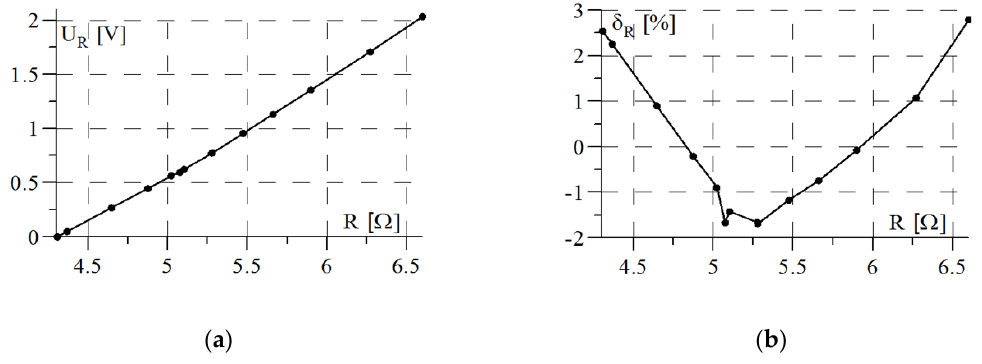
Figure 3. Characteristics of inductive sensor resistance measurement channel: ( a ) static; ( b ) relative nonlinearity error.